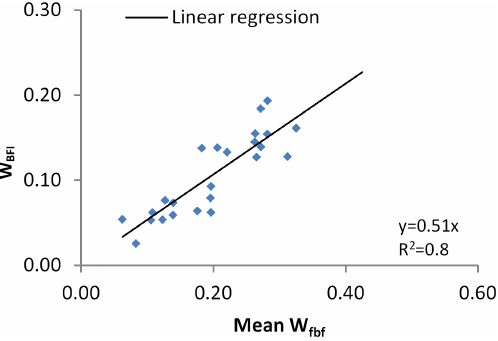
Figure 2. Scatterplot of uncertainty in BFI ( W BFI ) and mean uncer- tainty in f bf (mean W fbf